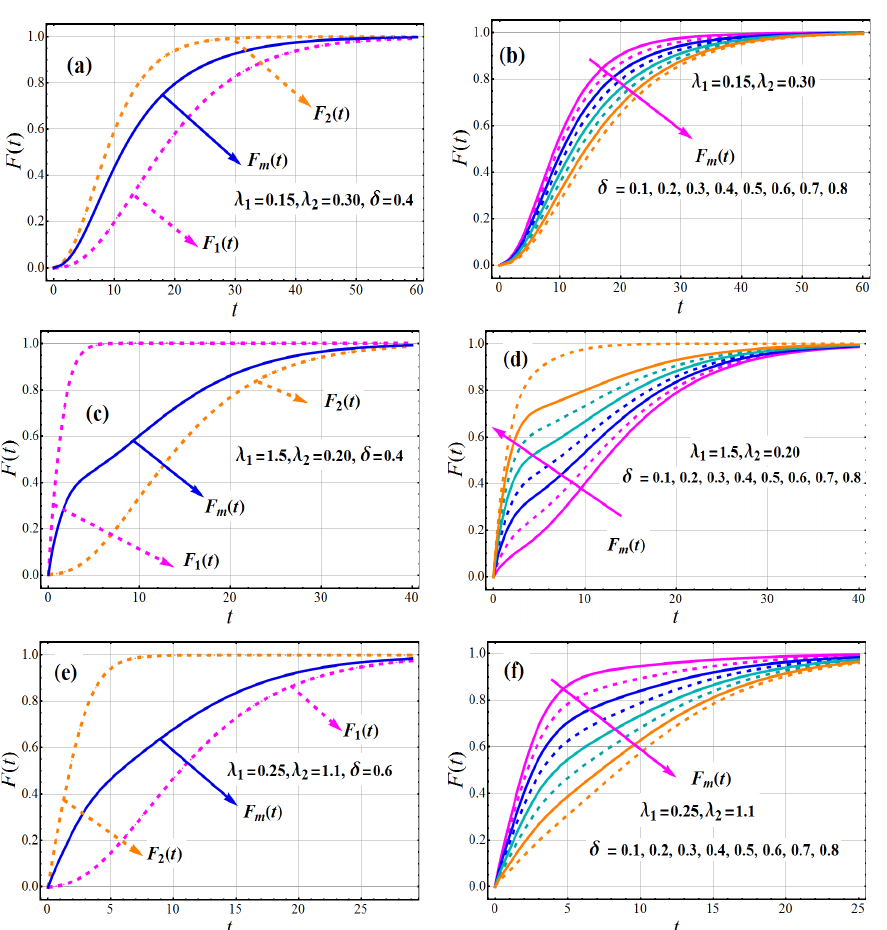
(cid:21) ( t ) (second component CDF) 2 2 j